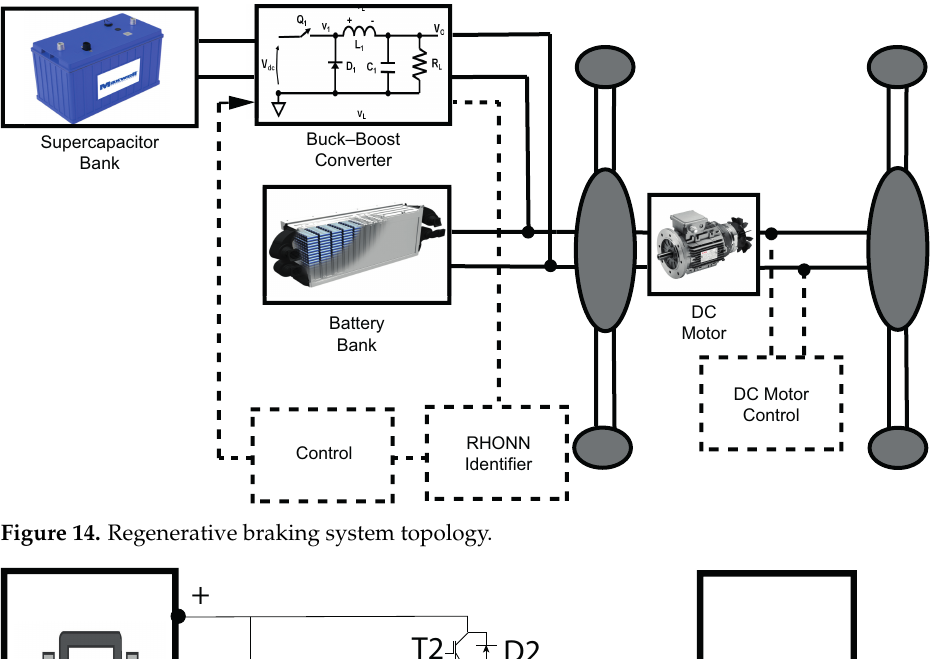
Figure 14. Regenerative braking system topology.